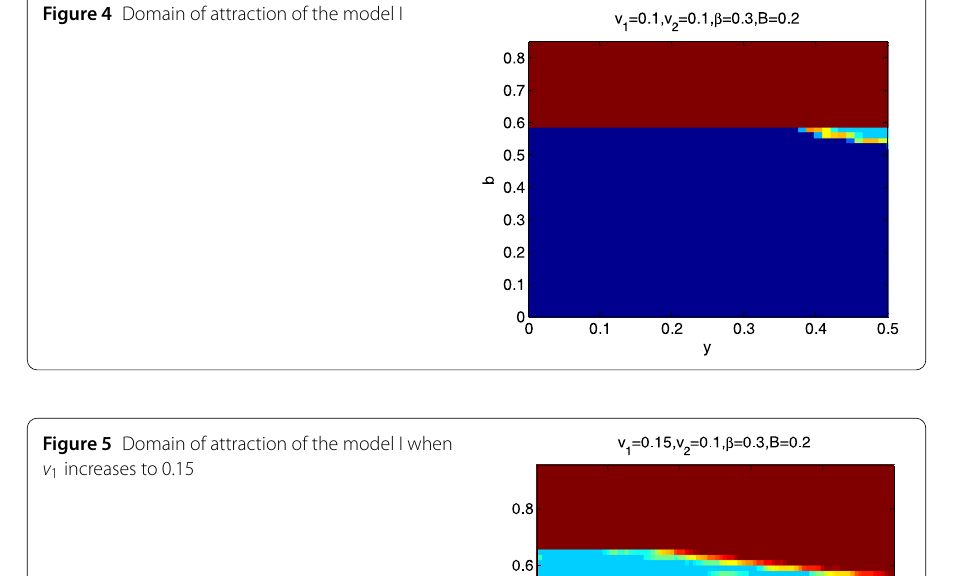
Figure 5 Domain of attraction of the model I when v